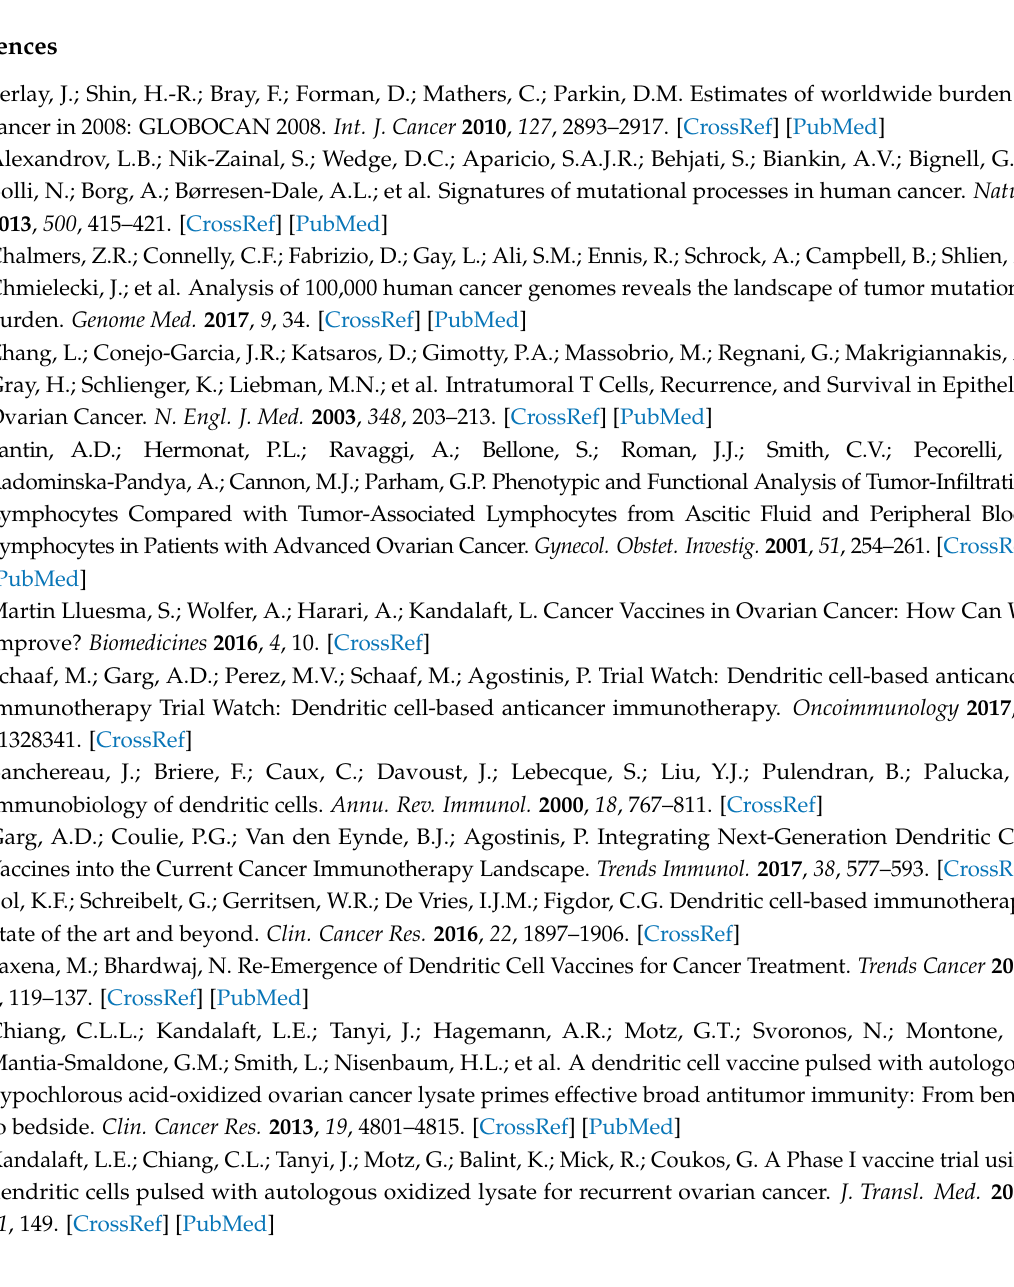
Figure S1: Example of the gating strategy for DCs and for the surface marker CD86, Figure S2: DCs matured with a two-step protocol in the presence of anti-CD40 and anti-IL10R antibodies for 24 h, followed by LPS/IFN γ /CpG stimulate a more Th1-skewed T cell response compared to canonical LPS/IFN γ